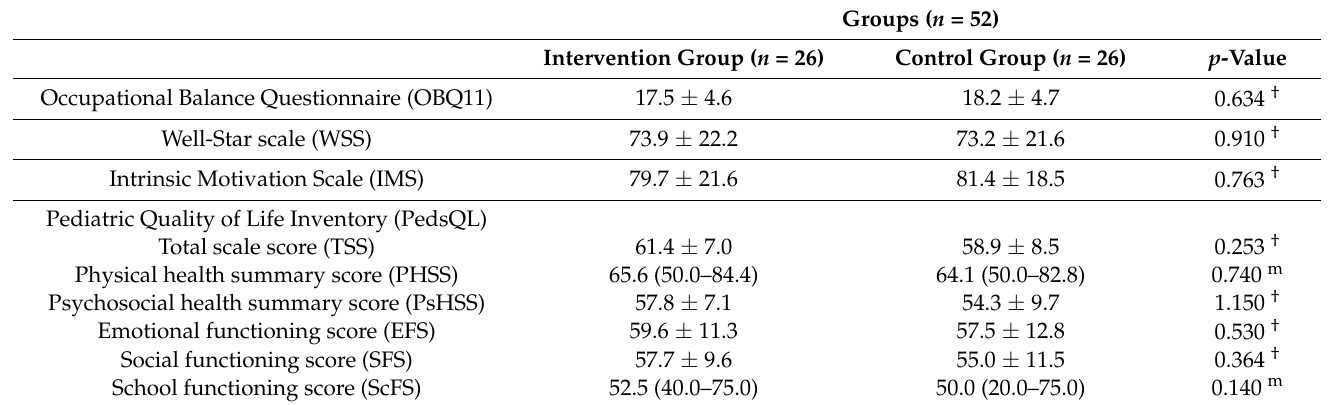
Table 5. Comparison of the baseline scores of the study scales.